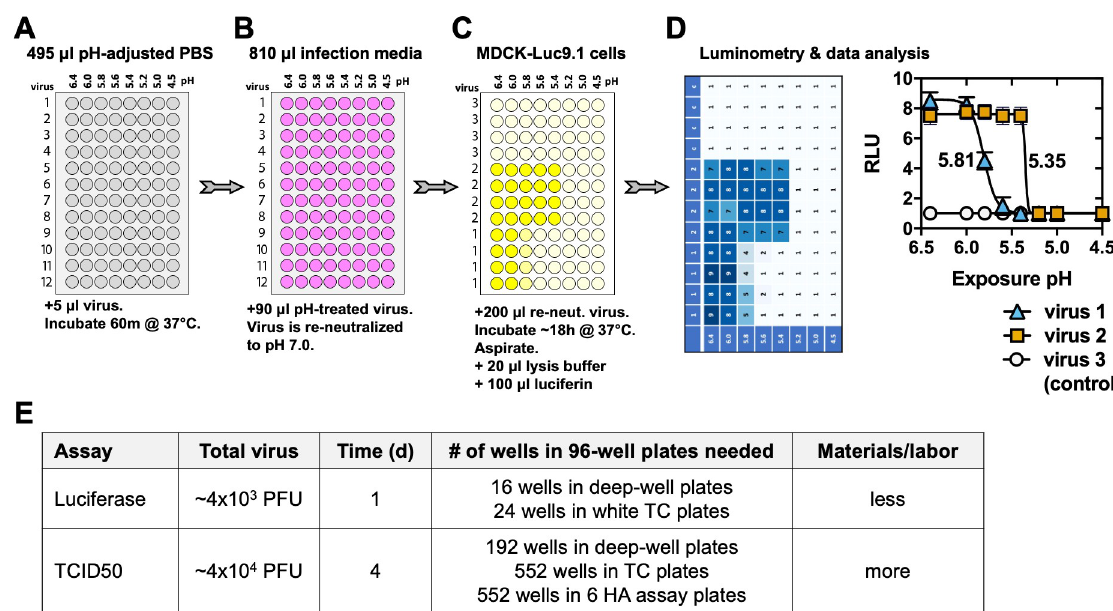
Fig 1. Schematic of luciferase reporter assay to measure influenza virus inactivation pH. (A) Acid treatment of samples. Into each well of a 96 deep-well plate, 495 μ l of pH-adjusted PBS is added. 5- μ l aliquots of twelve virus or control samples are added to eight wells each and incubated at 37˚C for 1h. (B) Re-neutralization. A multichannel pipette is used to transfer 90 μ l of sample from panel A into 810 μ l infection media that has a pH of 7.0. (C) Infection of reporter cells. A multichannel pipette is used to transfer 200 μ l re-neutralized virus to a white 96-well tissue culture (TC) dish containing MDCK-Luc9.1 cells. After 17-19h incubation at 37˚C and 5% CO 2 , media is aspirated, 20 μ l of lysis buffer is added, and 100 μ l of diluted Renilla luciferase assay substrate is added. (D) Quantification of reporter gene expression and calculation of virus inactivation pH. Luminescence is measured using a plate-reader luminometer. Relative light units (RLUs) are output to csv files, which are then analyzed in GraphPad Prism 8 to calculate the point of inflection by nonlinear regression with a dose-response equation. In this example, samples include virus 1 (calculated pH 5.81), virus 2 (calculated pH 5.35), and virus 3 (control virus, used to estimate the baseline reading). RLU values were assigned for illustrative purposes only and are not real data. (E) Comparison of luciferase and TCID50 assays to measure virus inactivation pH. Total virus is an estimate of total PFUs needed for each assay. Time to conduct assay is after culturing of cells.